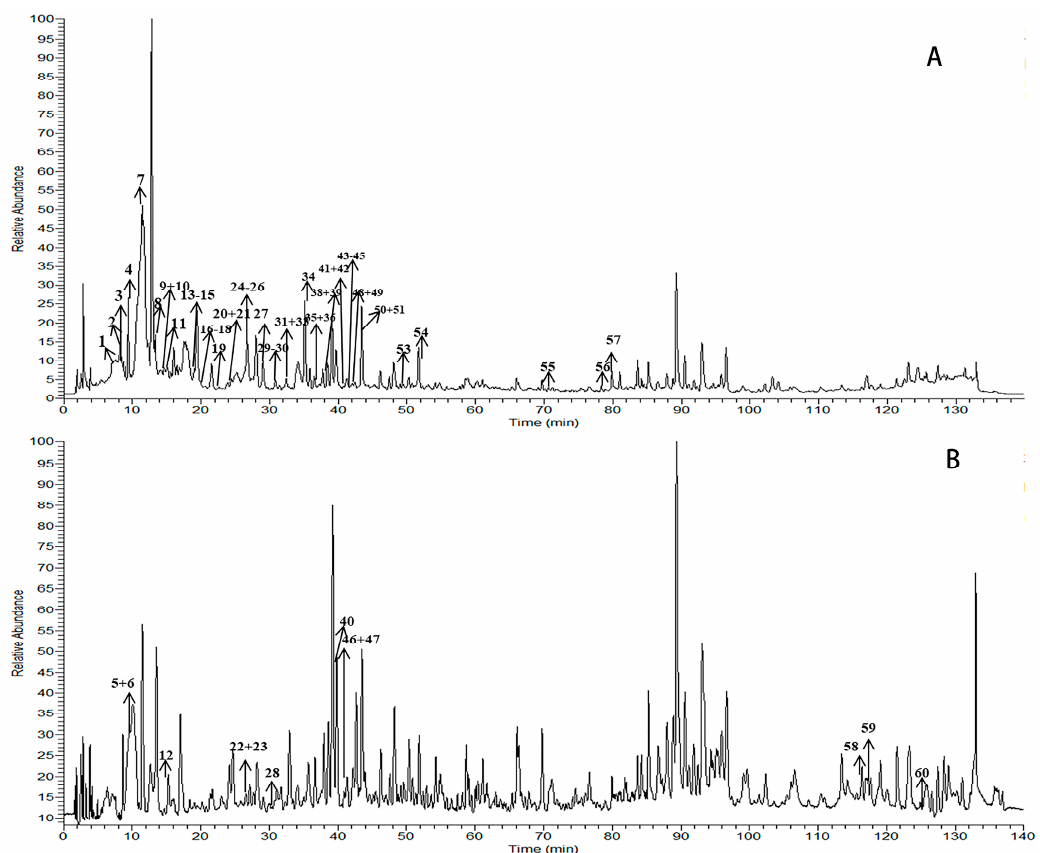
Figure 2. TIC chromatogram of T. sinensis : ( A ) positive ion mode; ( B ) negative ion mode.